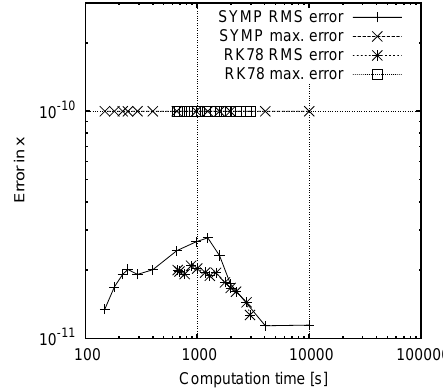
Fig. 13. The root mean square and maximum errors of the x -coordinate in the rotat- ing frame with respect to the Poincar´e section x = 0.